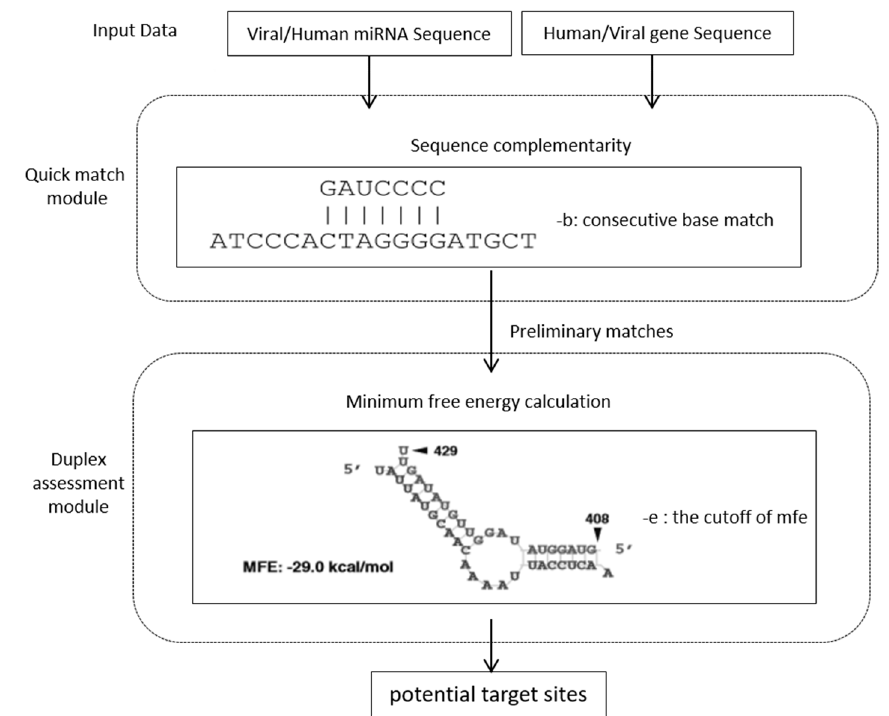
Figure 1. Flow chart of mirTarP for human–virus interspecies miRNA target prediction. The parameter ‘-b’ represents the number of consecutive base matches between miRNA and target sequence, while ‘-e’ represents the cutoff of minimum free energy of miRNA-target binding.